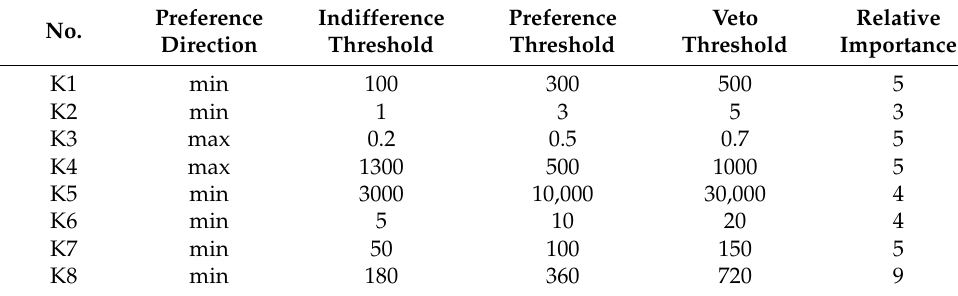
Table 6. Decision-maker’s preference model—Expert 3—academic